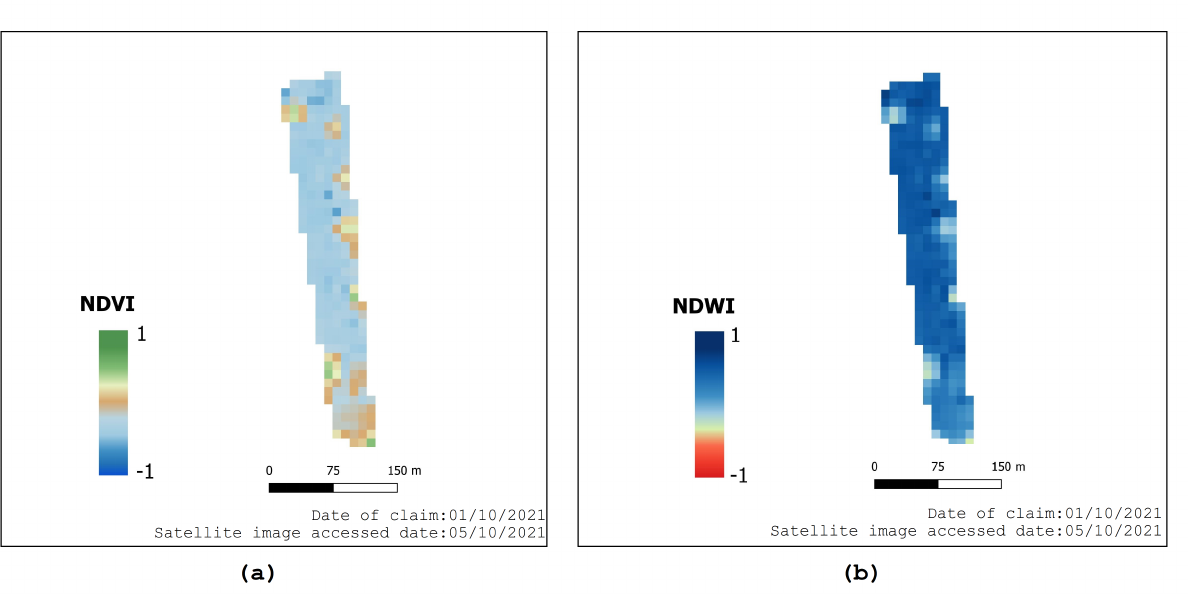
Figure 4. A sample plot with ( a ) NDVI and ( b ) NDWI calculation to detect flood in each pixel obtained from a Sentinel-2A image.